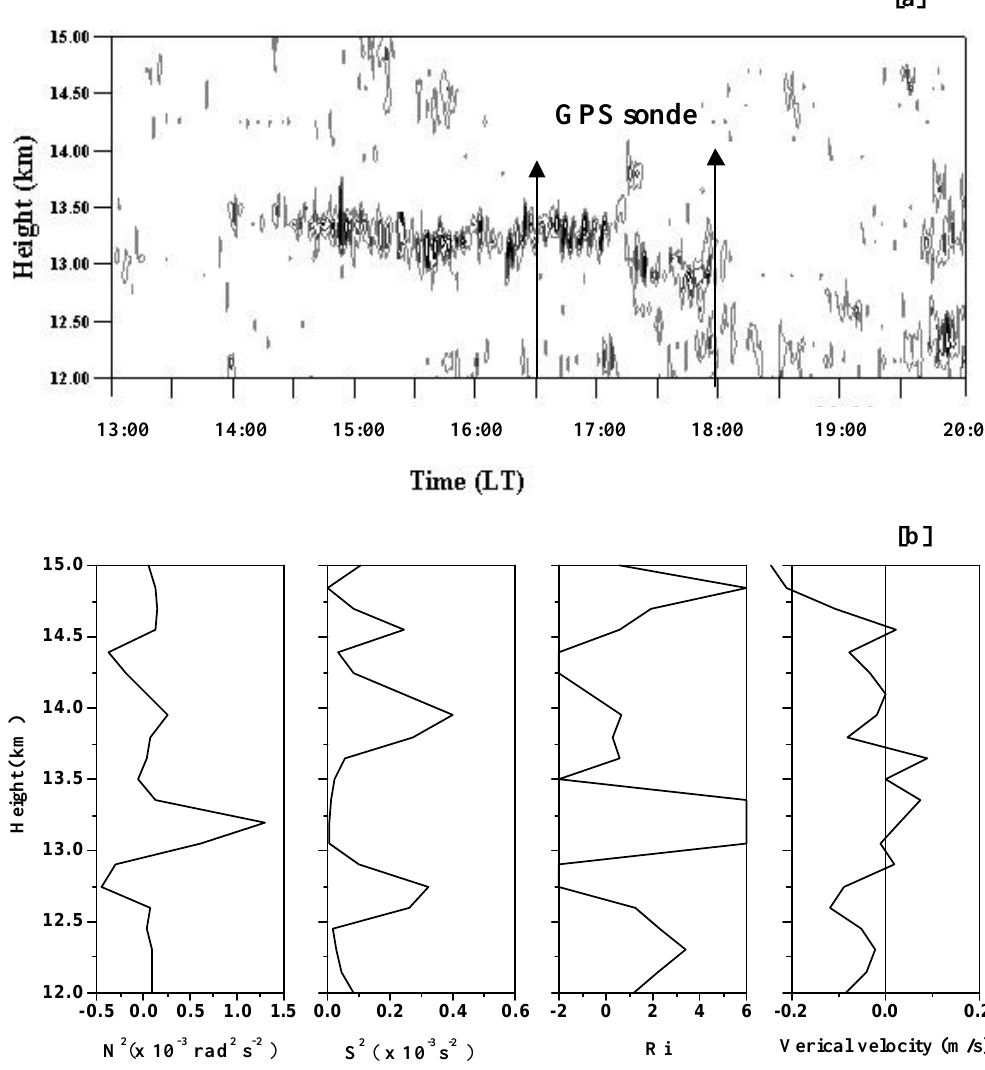
Fig. 6. Height-time-intensity plot of power burst pattern for 25 September 2002 from 12–15km (upper panel). Lower panel shows the height profiles of N 2 , square of vertical shear, R i and vertical